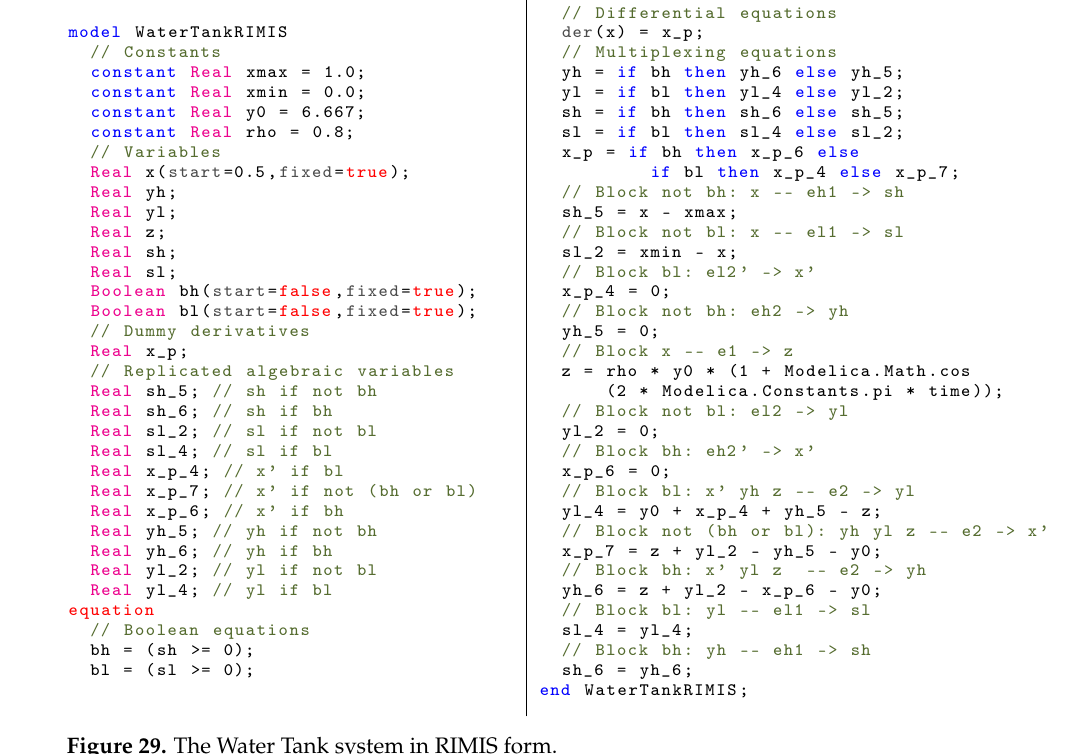
Figure 29. The Water Tank system in RIMIS form.